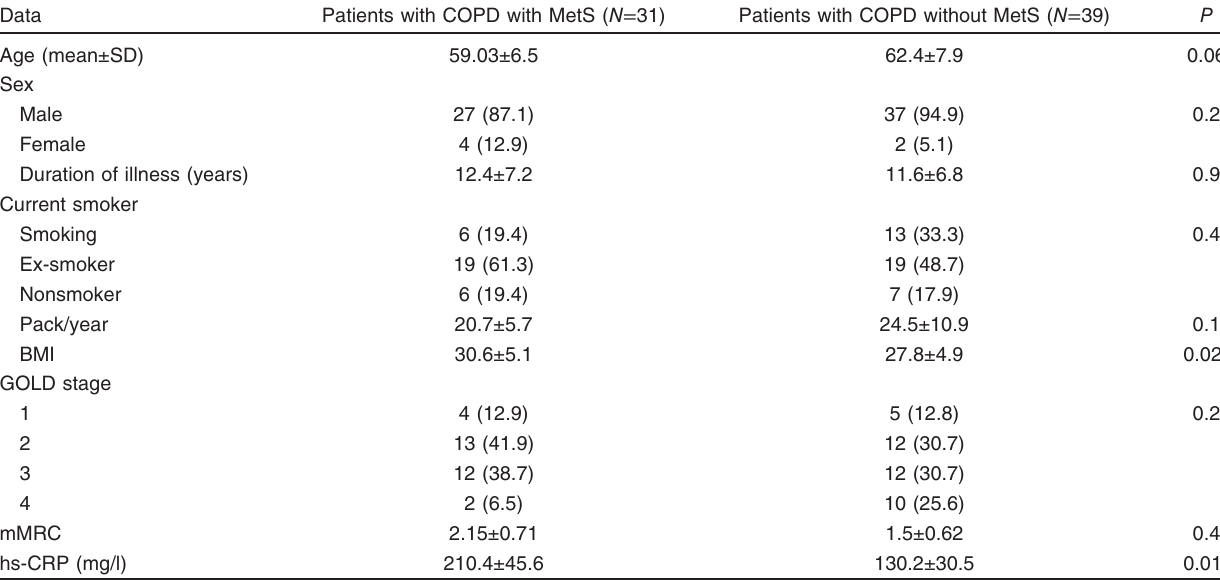
Table 1 Comparison of clinical characteristics of patients with chronic obstructive pulmonary disease with and without metabolic syndrome